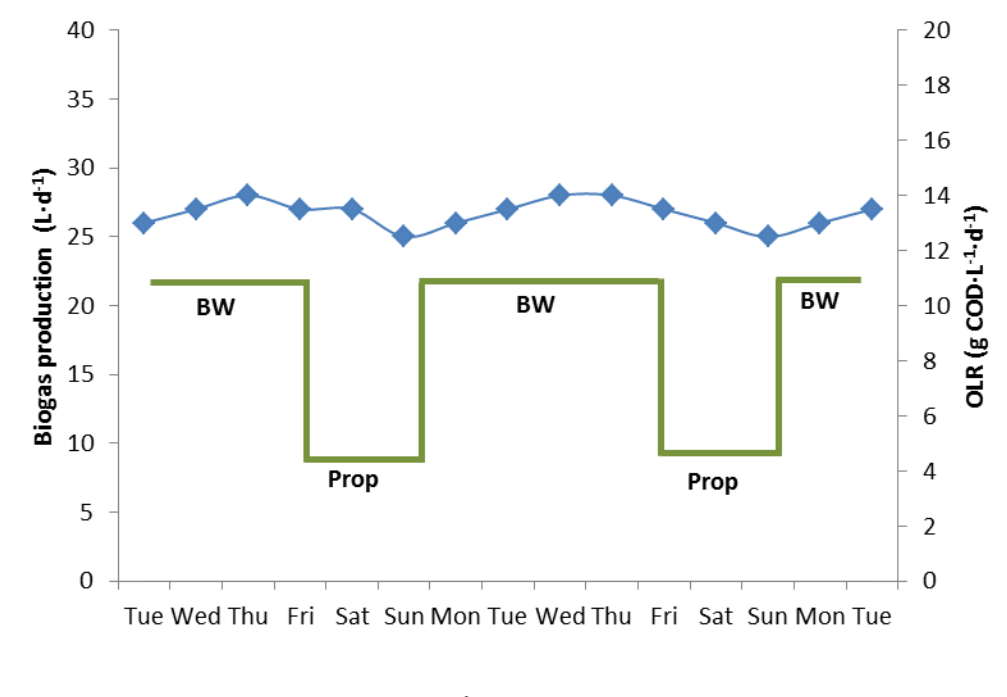
Figure 4. Periodic feeding of biowaste (BW, 1 L·d −1 ) or propionate (Prop, 2.68 M, 120 mL·d −1 ) to maintain an almost constant gas production in the 10 L biowaste reactor 4 over weekends, when no biowaste was available. No fatty acids were detected at any